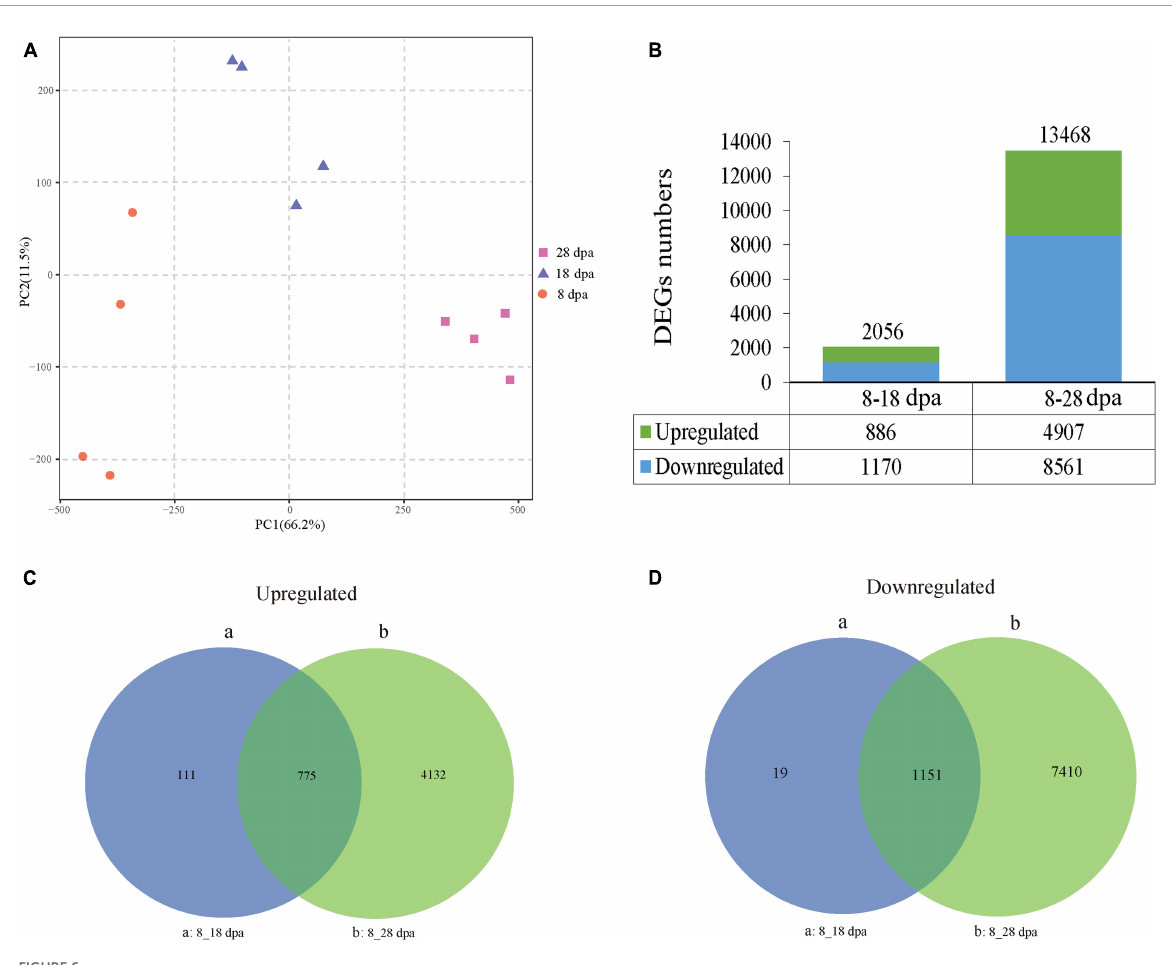
to thiamine and SA, respectively ( Supplementary File 5